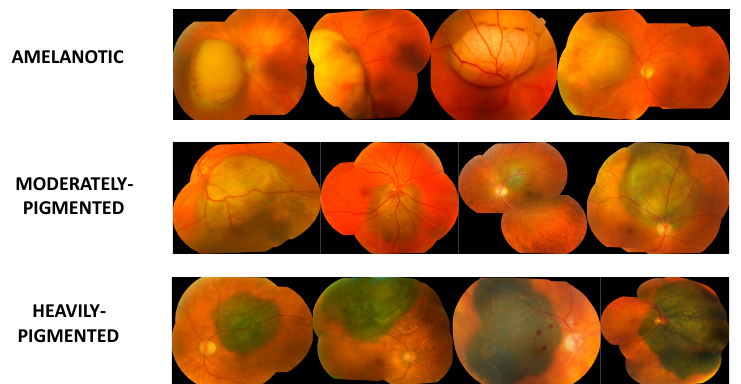
Figure 1. Clinical examples of the different pigmentation of uveal melanomas in each of categories assessed in the indirect ophthalmoscopy.